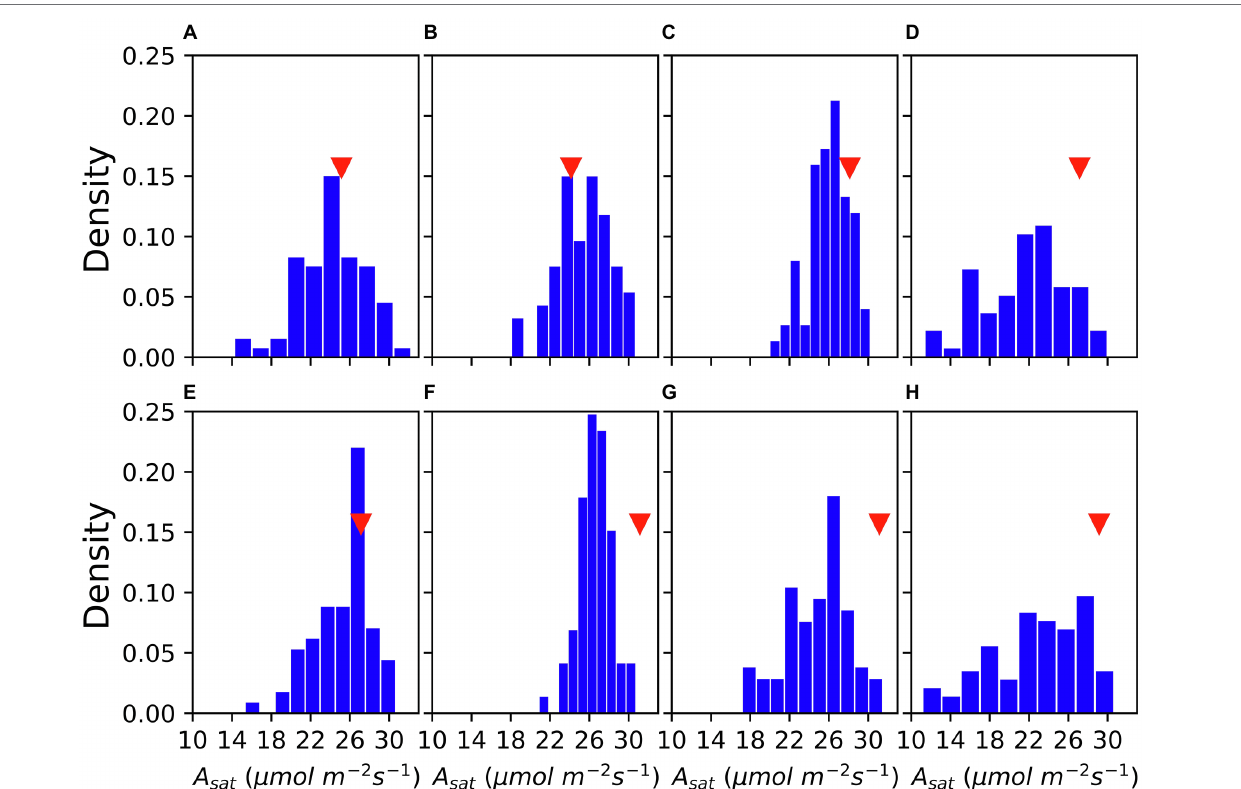
FIGURE 1 | Variation of A sat in the GmJMC (JMC) accessions and its comparison with Fukuyutaka (Fu) across measurements. 5 August, 2019 (A) 13 August, 2019 (B) 18 August, 2019 (C) 6 August, 2020 (D) 14 August, 2020 (E) 21 August, 2020 (F) 27 August, 2020 (G) and 31 August, 2020 (H) . Red triangles show the A sat performance of Fu.